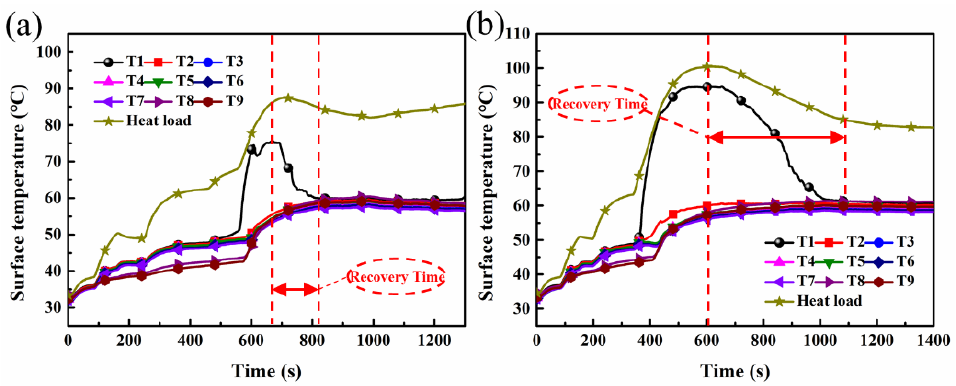
Figure 7. The recovery characteristics of TSHP-1 with heat load B input of 10 W after the surface temperature of T1 increased to ( a ) 75 °C and ( b ) 94 °C caused by heat load A input up to 65 W.